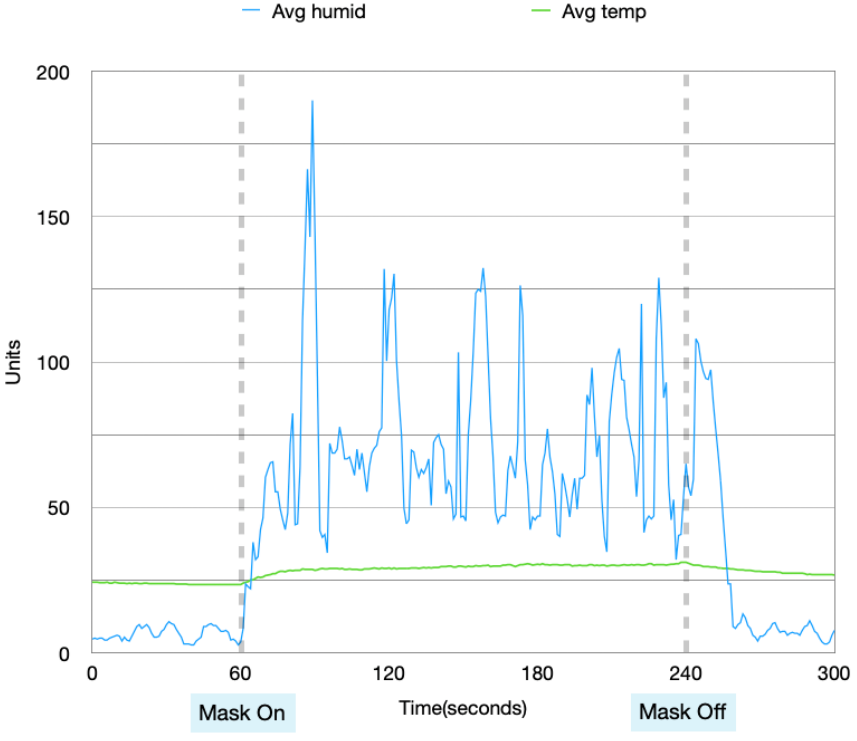
Figure 7. Data collected during the night, with prior physical